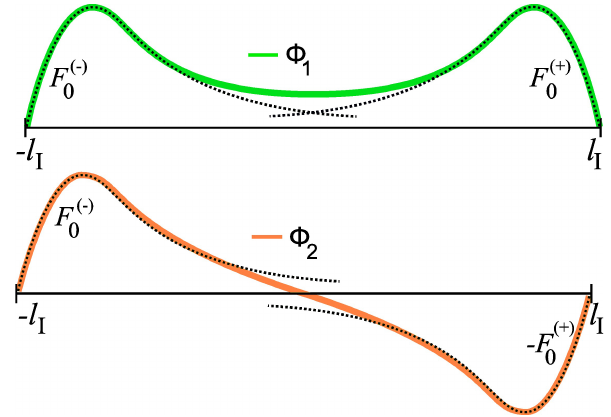
Fig. 4. Two principal harmonics of the wave potential 8